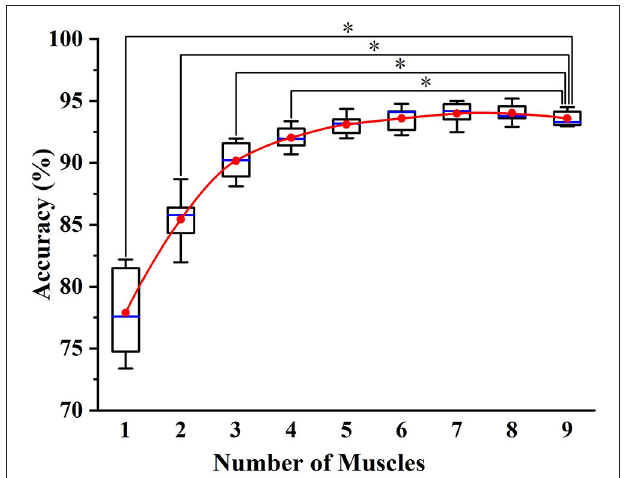
FIGURE 7 | The classification results of the optimal muscle subsets based on different muscle numbers. * indicates a statistically significant difference (one-way ANOVA, P <